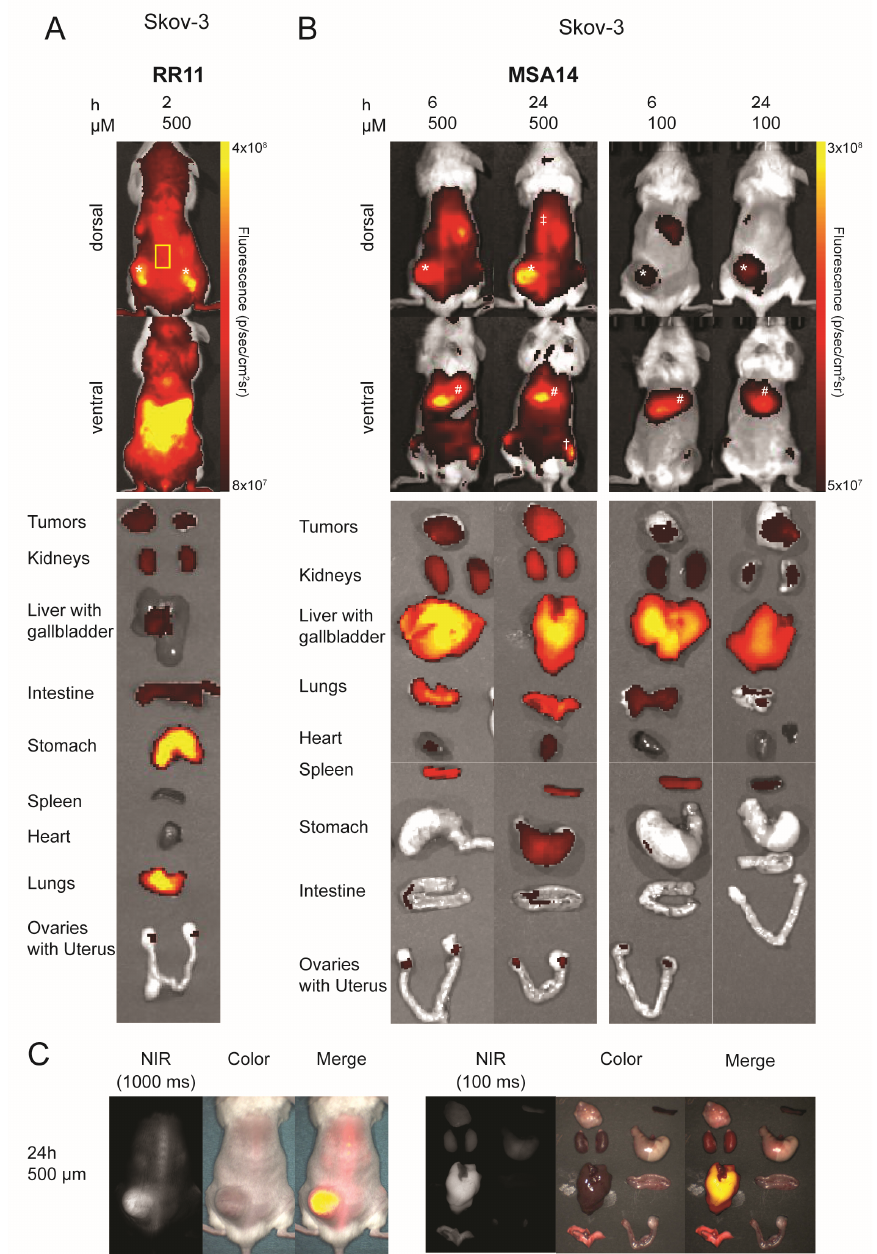
Figure 5. Biodistribution of RR11 and 23 ( MSA14 ) in SKOV-3 s.c. models. RR11 ( A ) and 23 ( MSA14 ) ( B ) were intravenously injected into n = 2 and n = 4 mice, respectively, and imaged at 2, 6, and 24 h with a dose of 500 and 100 µ M. The fluorescence signal in the tumors (*), liver (#), limb (†), spine (‡) and background in the flank muscle (yellow square), is presented in one representative mouse. All animals were euthanized when indicated and “ex vivo” NIR FLI was performed. ( C ) 23 (MSA14) injected SKOV-3 mice were additionally imaged with the intraoperative imaging system “in vivo” and “ex vivo”. NIR exposure times are indicated in